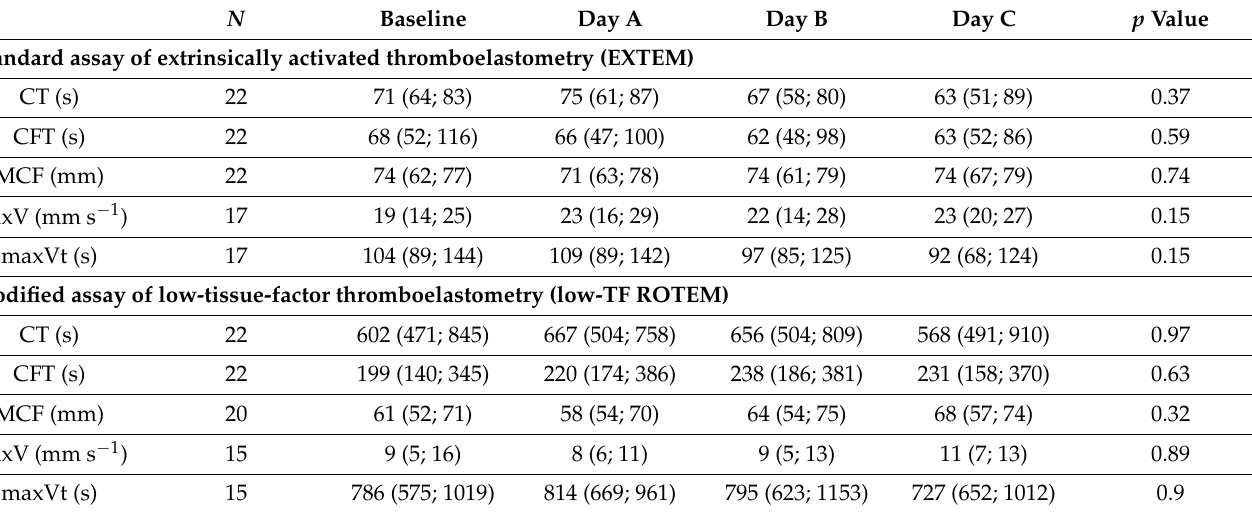
Figure 1. Plasma anti-Xa levels at baseline and during each day in the ICU. Target levels for (semi)therapeutic anticoagulation are indicated by the pink zone, whereas the gray zone at the bottom has been populated with random values down to zero to illustrate results below the detection limit of the test (<0.1 IU mL − 1 ). Table 3. Results of the various standard and modified rotational thromboelastometry